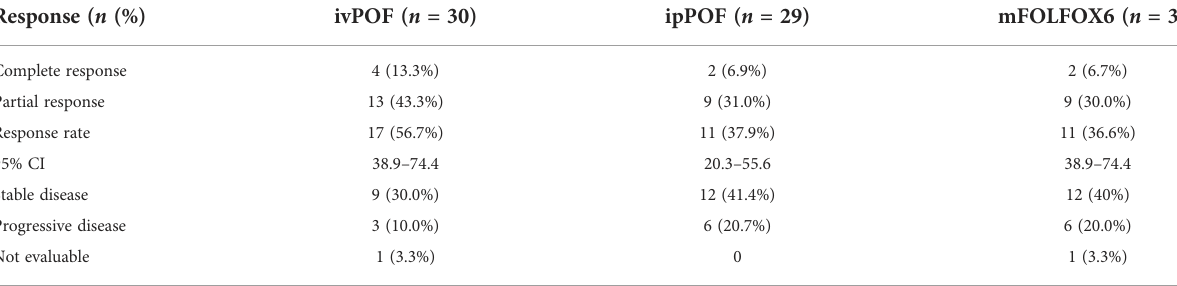
TABLE 2 Best overall response